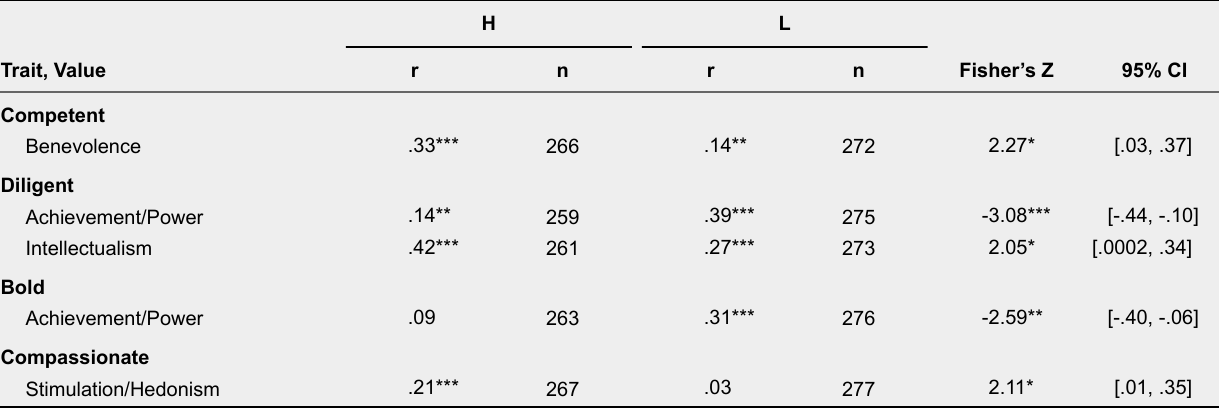
Difference Between High-Income and Low-Income